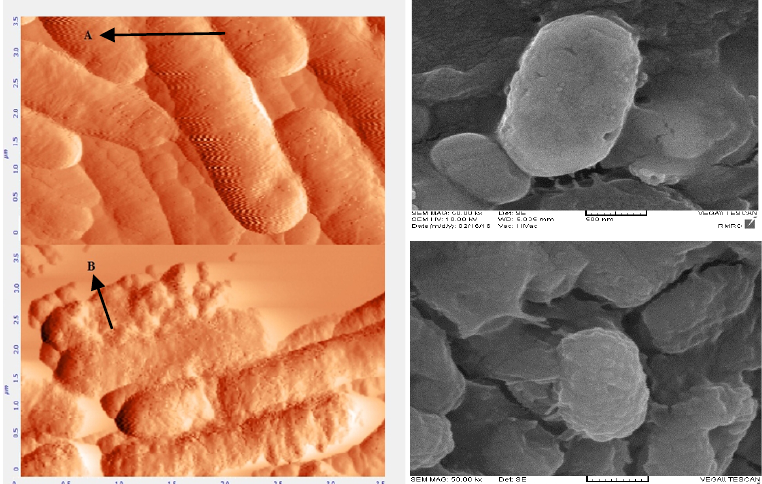
Fig. 3. AFM amplitude image of (A) CKCr-6A grown in the absence of Cr(VI) as a control and (B) grown in the presence of chromium. SEM micrographs of Alcaligenes sp. cells grown in: (C) LB medium without Cr(VI); (D) LB medium amended with 50 mg L −1 Cr(VI) for 24